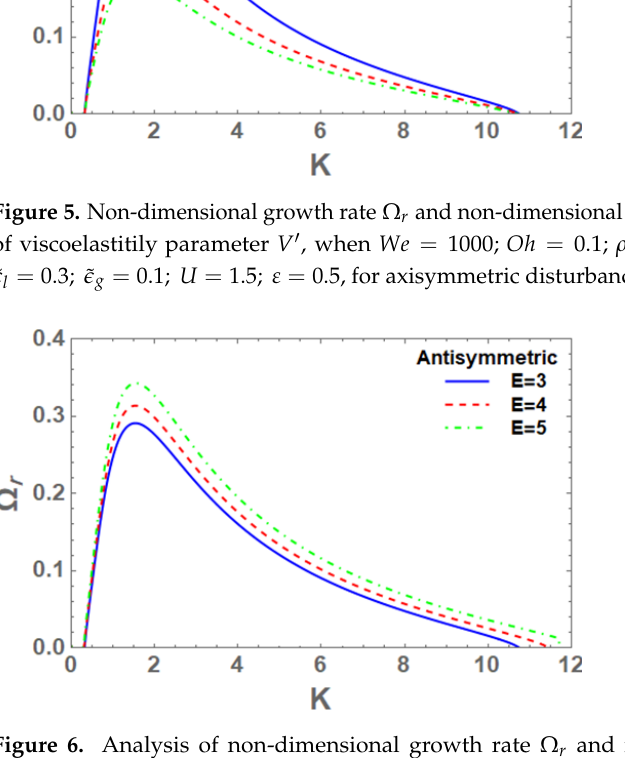
Figure 6. Analysis of non-dimensional growth rate Ω r and non-dimensional wave number K for different electric field strengths E , when We = 1000; Oh = 0.1; ρ = 0.01; N = 1; v = 0.2; ˜ (cid:101) l = 0.3; ˜ (cid:101) g = 0.1; E = 3; U = 1.5; V (cid:48) = 0.1; ε = 0.5, for axisymmetric disturbance case.